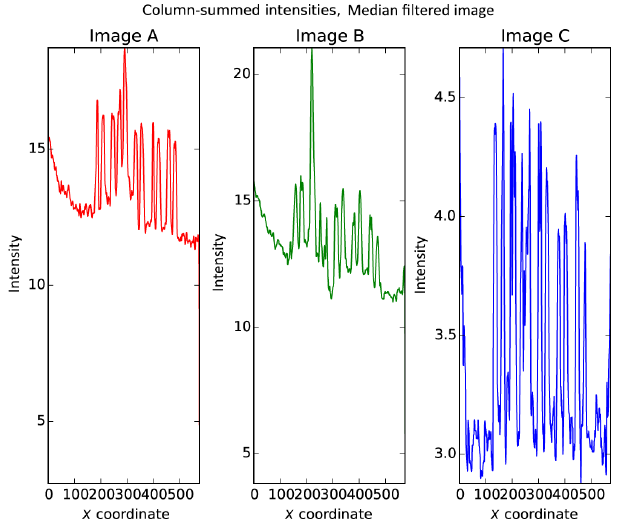
Figure 10. The column-summed intensities for images A, B and C (Figs. 4, 5 and 6) after squaring the pixel intensities.